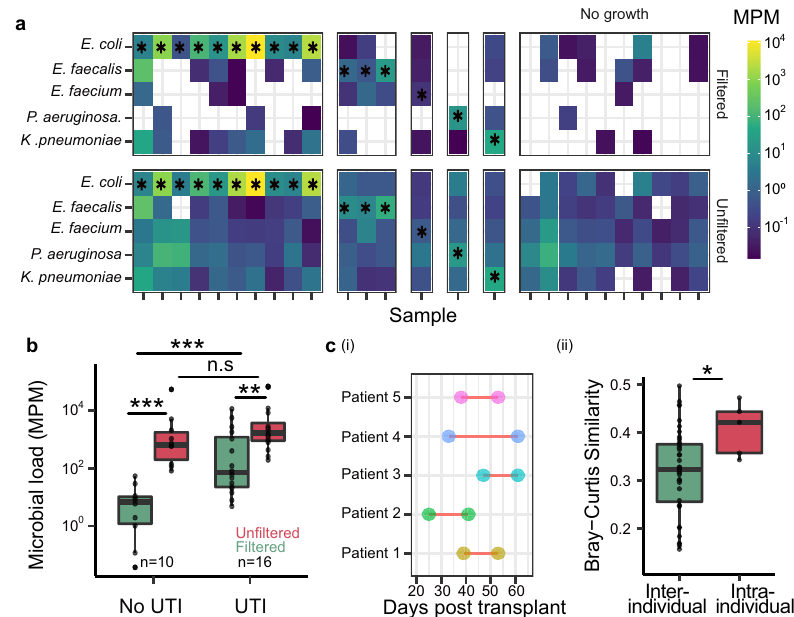
Fig. 3 Application of SIFT-seq to urine. a Heatmap of abundance of species (molecules per million, MPM, species with at least one read detected by BLAST) identi fi ed in patients with and without urine culture-con fi rmed UTIs, before and after application of SIFT-seq fi lter (black * indicates agreement with urine culture). b Boxplot of the relative number of microbe-derived molecules (MPM) in samples from patients with and without urine culture-con fi rmed UTIs, before and after SIFT-seq fi ltering. c ( i ) Sample collection timepoints after transplantation for 5 patients. ( ii ) Boxplot showing Bray – Curtis similarity index (as de fi ned in c ( i )) of the urine microbiome within individual patients and between patients before and after stent removal. Boxes in the boxplots indicates 25th and 75th percentile, the band in the box indicated the median and whiskers extend to 1.5×Interquartile Range (IQR) of the hinge. Outliers (beyond 1.5× IQR) are plotted individually. (* p value< 0.05, ** p value< 0.01,*** p value <0.001). Source data for ( a – c (ii)) are provided as a source data fi